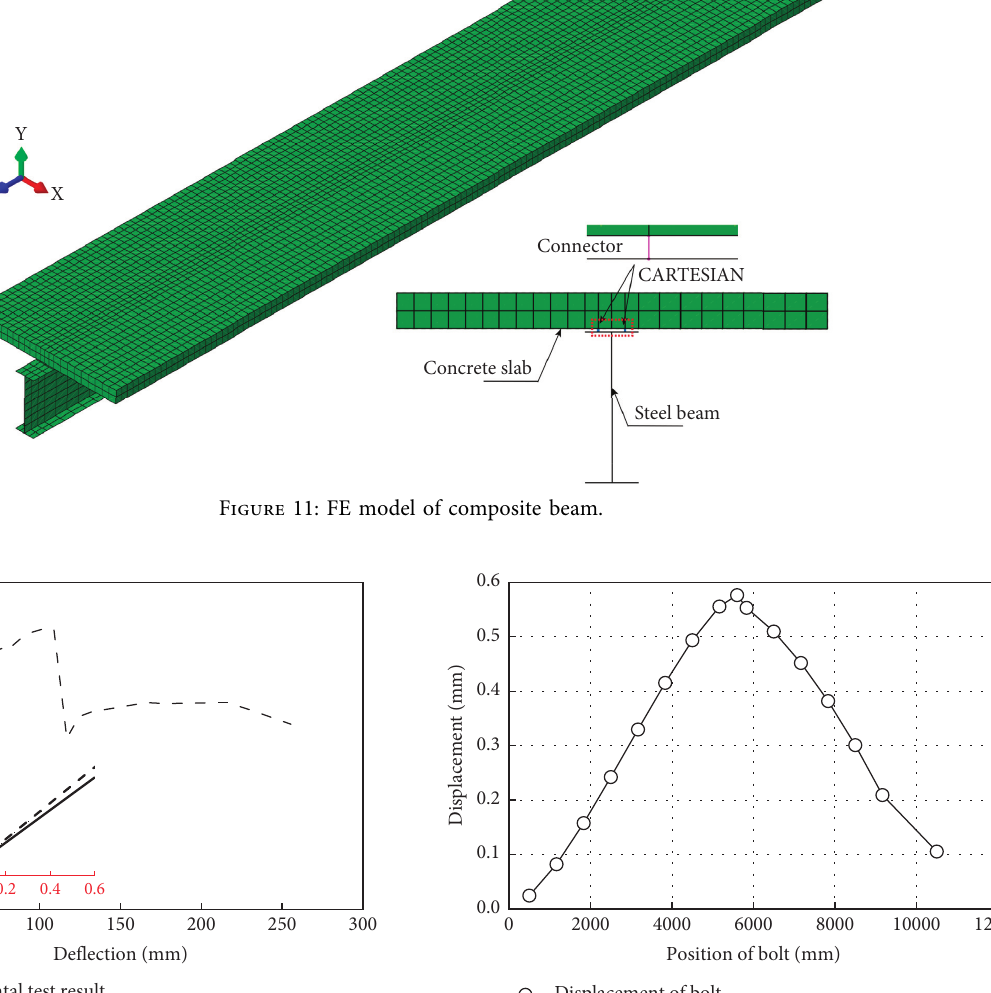
Figure 13: The displacements of the connectors in the elastic stage.